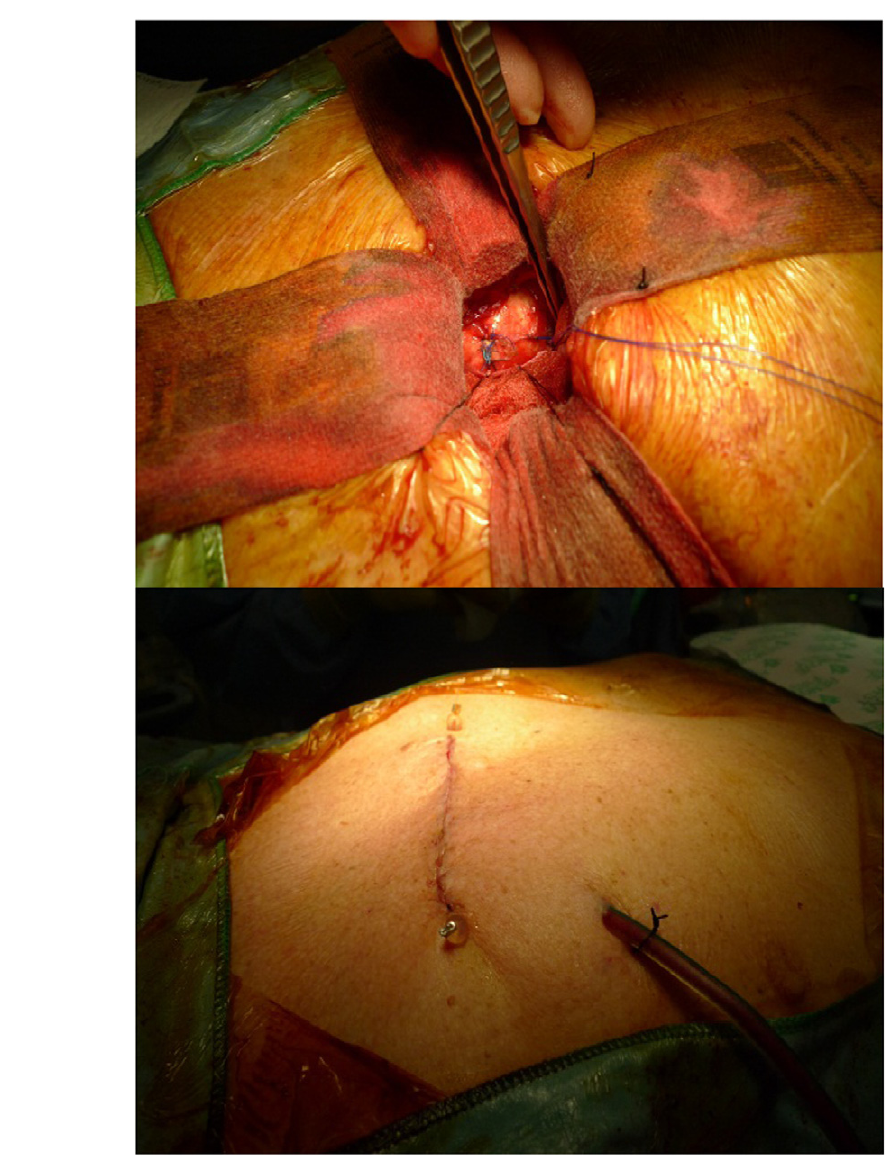
Figure 7b. Cont. Step-by-step TAVI via direct aortic approach. Top: Purse-string closure of sheath entry site with good haemostasis. Bottom: Wound closed in layers with drain left in-situ. A steep learning curve has been seen since the advent of this technology. With increasing implant experience there has been a gradual reduction in peri-procedural complications and improved clinical outcomes [36]. At present there is a paucity of long-term outcome data and until we have this, expansion of such technology into a lower risk patient cohort is tentative. Patients demonstrating clinical equipoise between surgical intervention and transcatheter implantation now represent the forefront for TAVI [37]. Data from the PARTNER 2 and SURTAVI trials will prove central to how transcatheter technology evolves and in what patient cohort it should